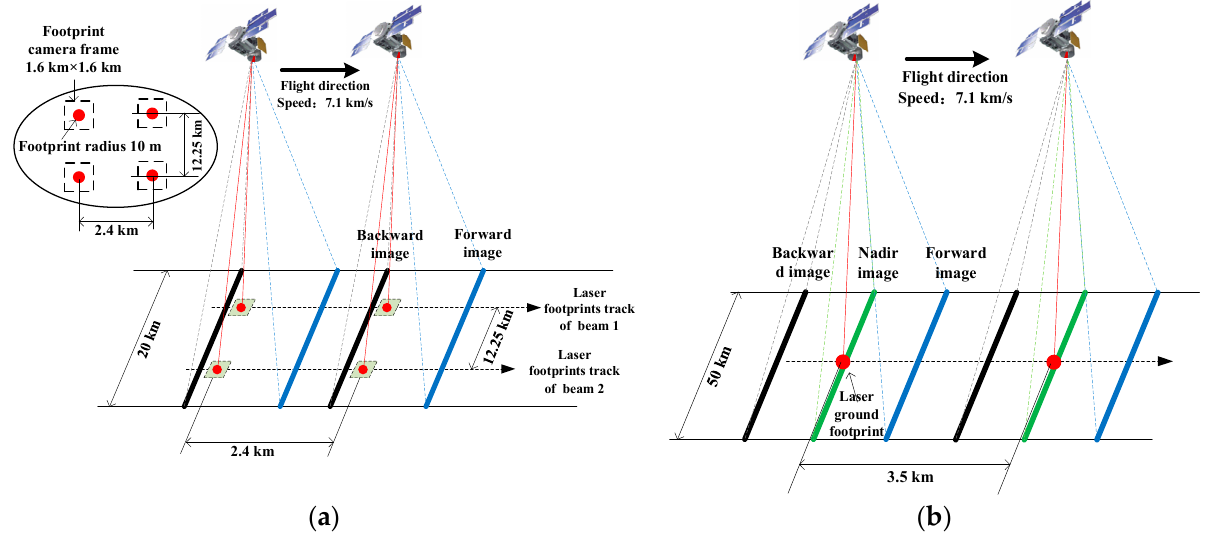
Figure 1. Schematic of stereo image and laser altimetry point (LAP) acquisition by the same satellite: ( a ) GF7, ( b ) ZY3-03.